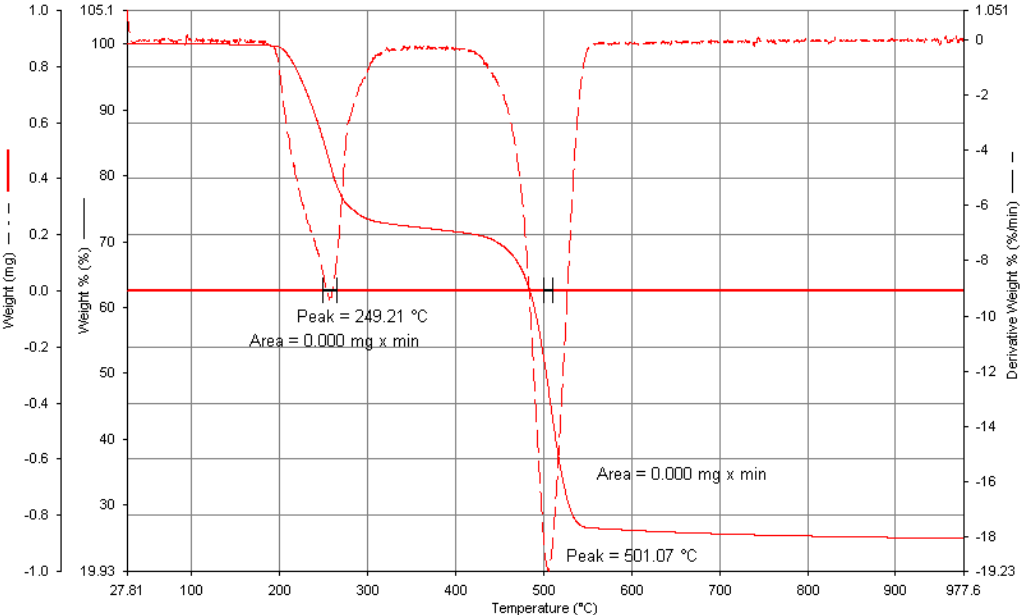
Figure 5. Thermogravimetric/Differntial thermal spectrum of zeolite Y. The zeolite was heated from 30–800 °C at a heating rate of 5 °C/min.